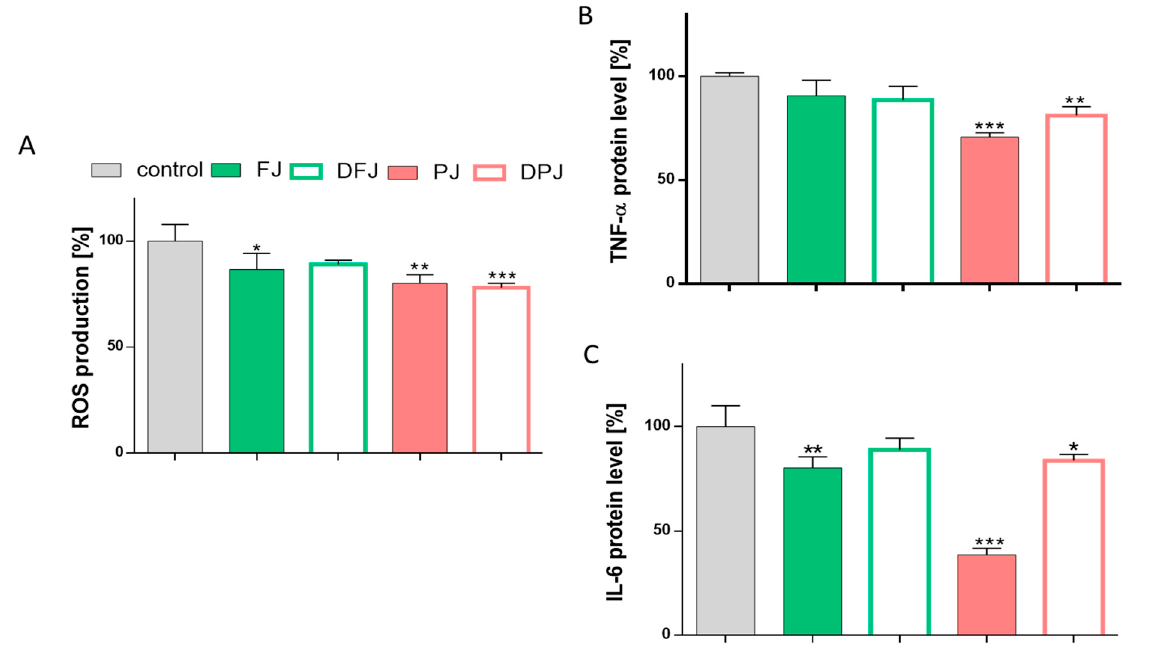
Figure 8. The influence of V. opulus fresh juice (FJ), digested fresh juice (DFJ), purified juice (PJ), and digested purified juice (DPJ) at non-cytotoxic concentration (IC 0 ) on intracellular ROS generation in differentiated 3T3-L1 cells after 7-day incubation ( A ); the secretion of tumor necrosis factor α (TNF- α ) ( B ); the secretion of interleukin-6 (IL-6) ( C ); control cells were not exposed to any compound except vehicle; values are means ± standard deviations from at least three independent experiments, n ≥ 9; statistical significance was calculated versus control cells (untreated), * p ≤ 0.05, ** p ≤ 0.01, *** p ≤ 0.001.